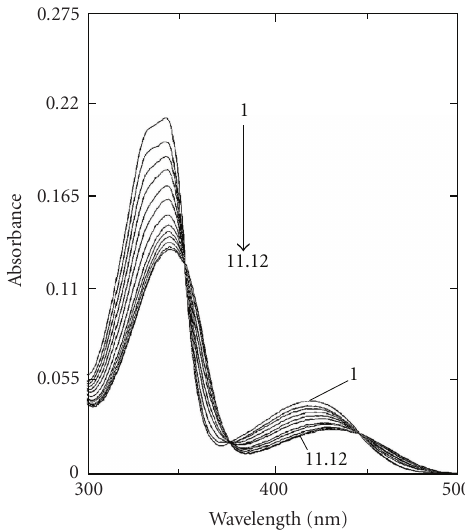
Figure 4: Absorption spectrum (1) of palmatine (7.6 μ M) with increasing concentrations up to 151.6 μ M (11) and 175.2 μ M (12) of calf thymus DNA. Reprinted from the Ph.D. Thesis of Bhadra